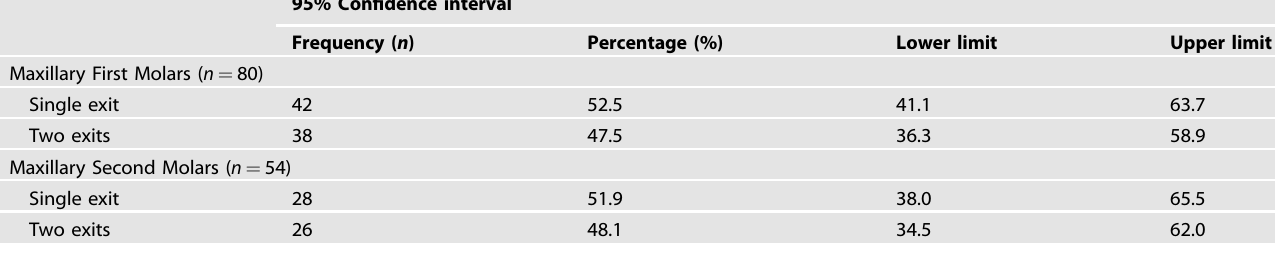
Table 4. Prevalence of the number of MB-2 exit(s) for each maxillary molar.